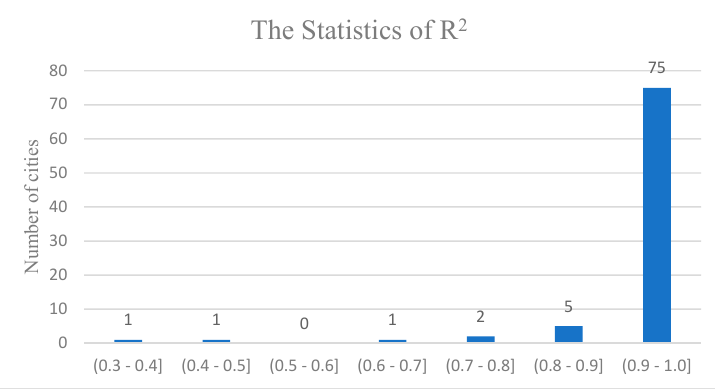
Figure 5. Statistics of R 2 calculated by the OSM road network density and population.